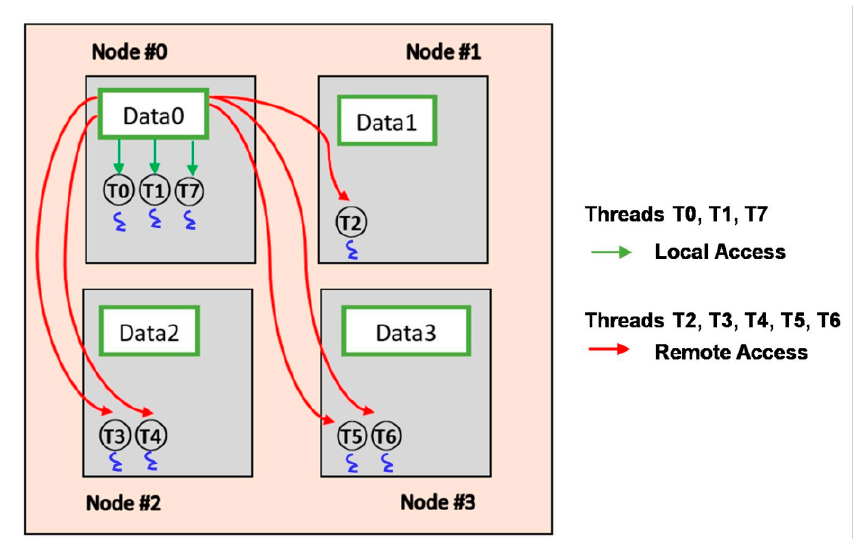
Figure 3. The memory pages and threads for a multithreaded process can be scattered on differ- ent nodes.